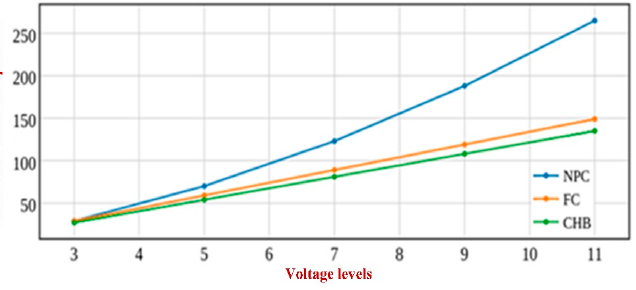
Figure 20. The total number of components utilized in a multilevel inverter for di ff erent levels.